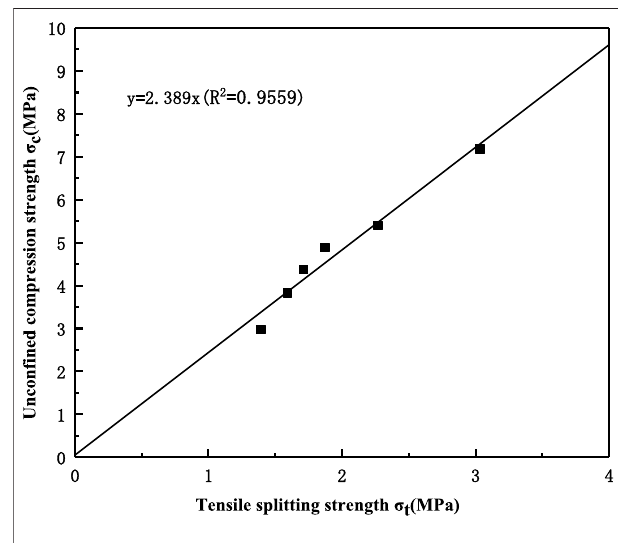
FIGURE 6 | Relationships between UCS and